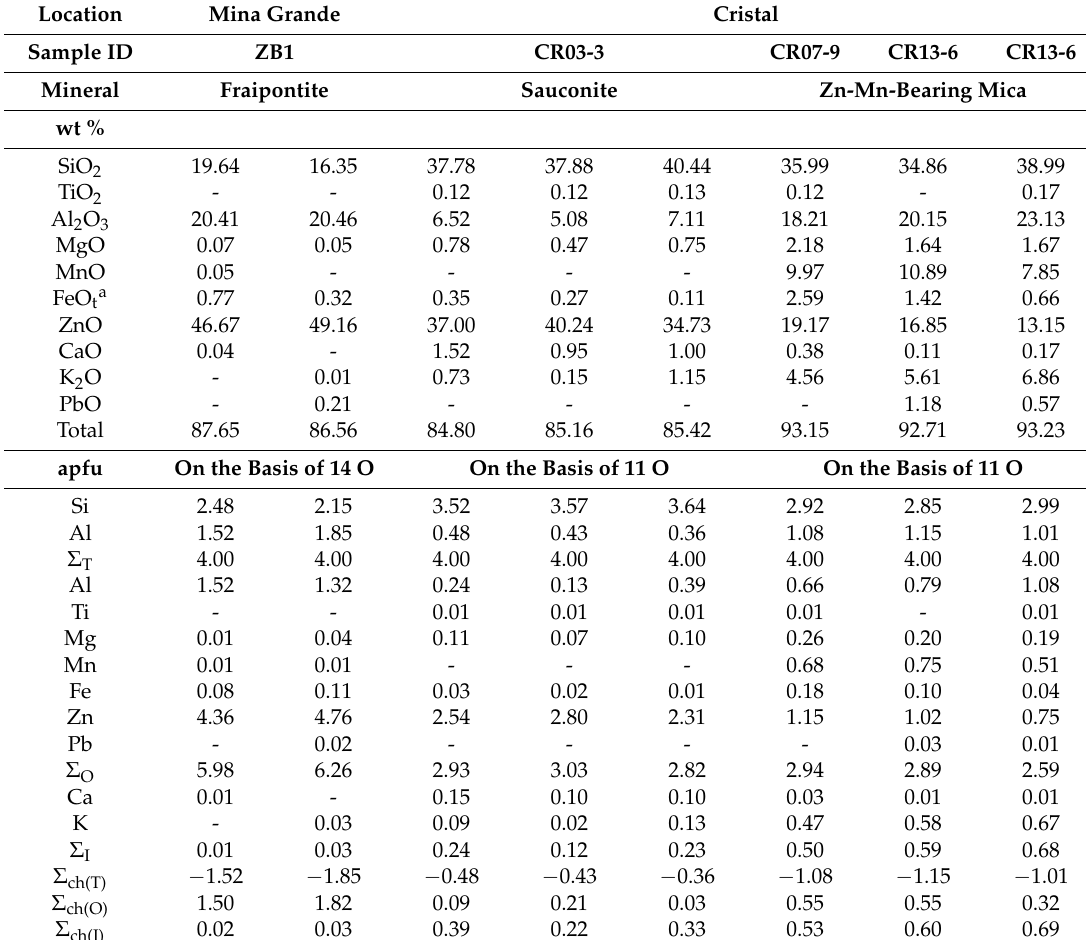
Table 2. Chemical compositions and structural formulae (apfu) of trioctahedral mineral species from the Mina Grande (fraipontite) and Cristal (sauconite and Zn-Mn-bearing mica)